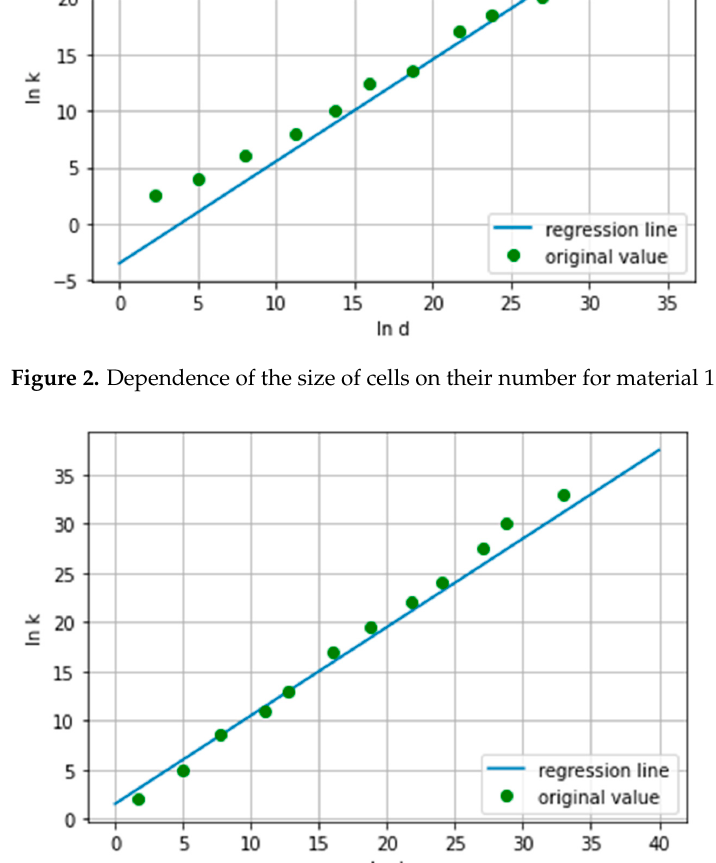
Figure 2. Dependence of the size of cells on their number for material 1 .